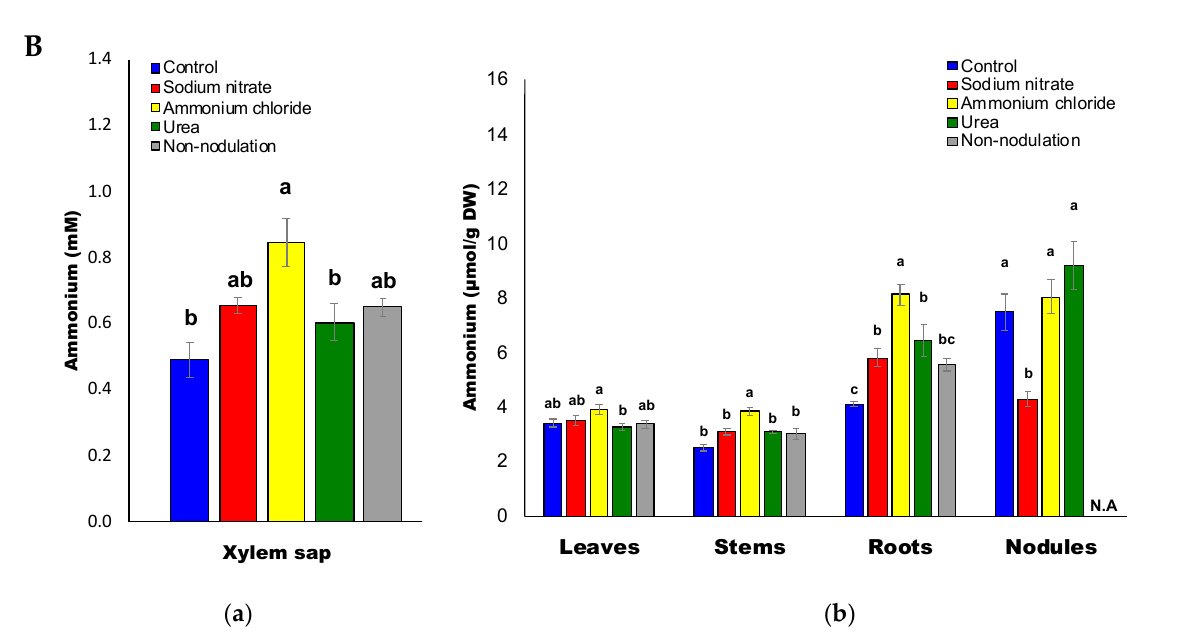
Figure 3. ( A ) Nitrate concentrations in the xylem sap ( a ) and in each part ( b ) of the soybean plant. ( B ) Ammonium concentrations in the xylem sap ( a ) and in each part ( b ) of the soybean plant. N.A: not available; N.D: not detected.